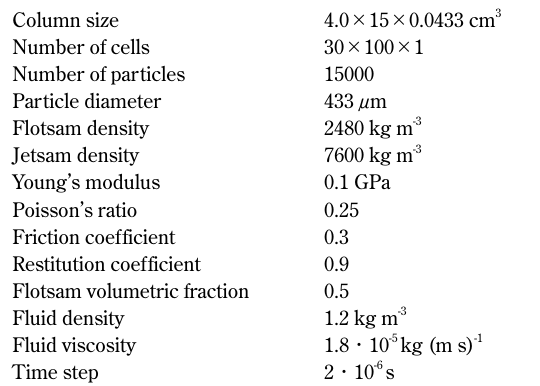
Table 2 System data and parameters used in the simulations